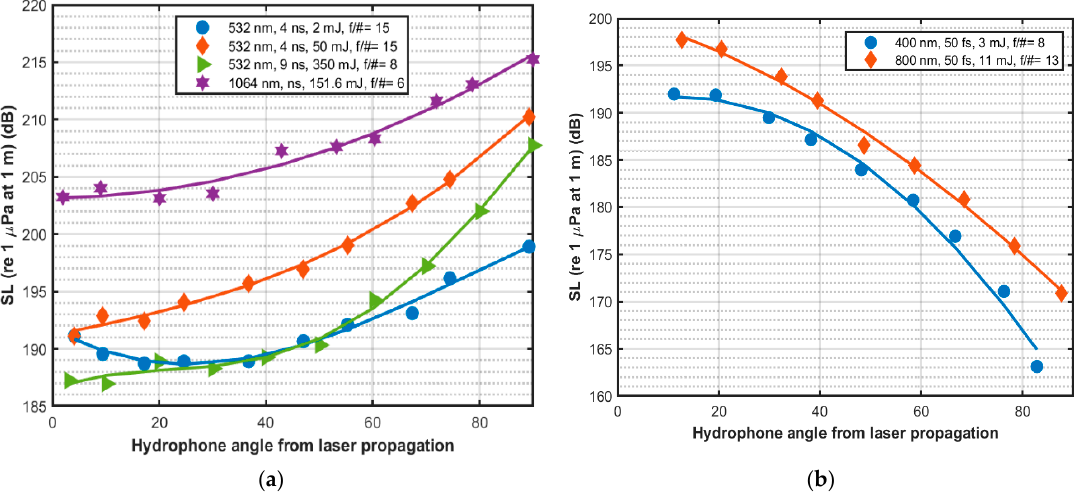
Figure 12. Acoustic source directionality for ( a ) narrowband nanosecond laser and ( b ) broadband femtosecond laser.